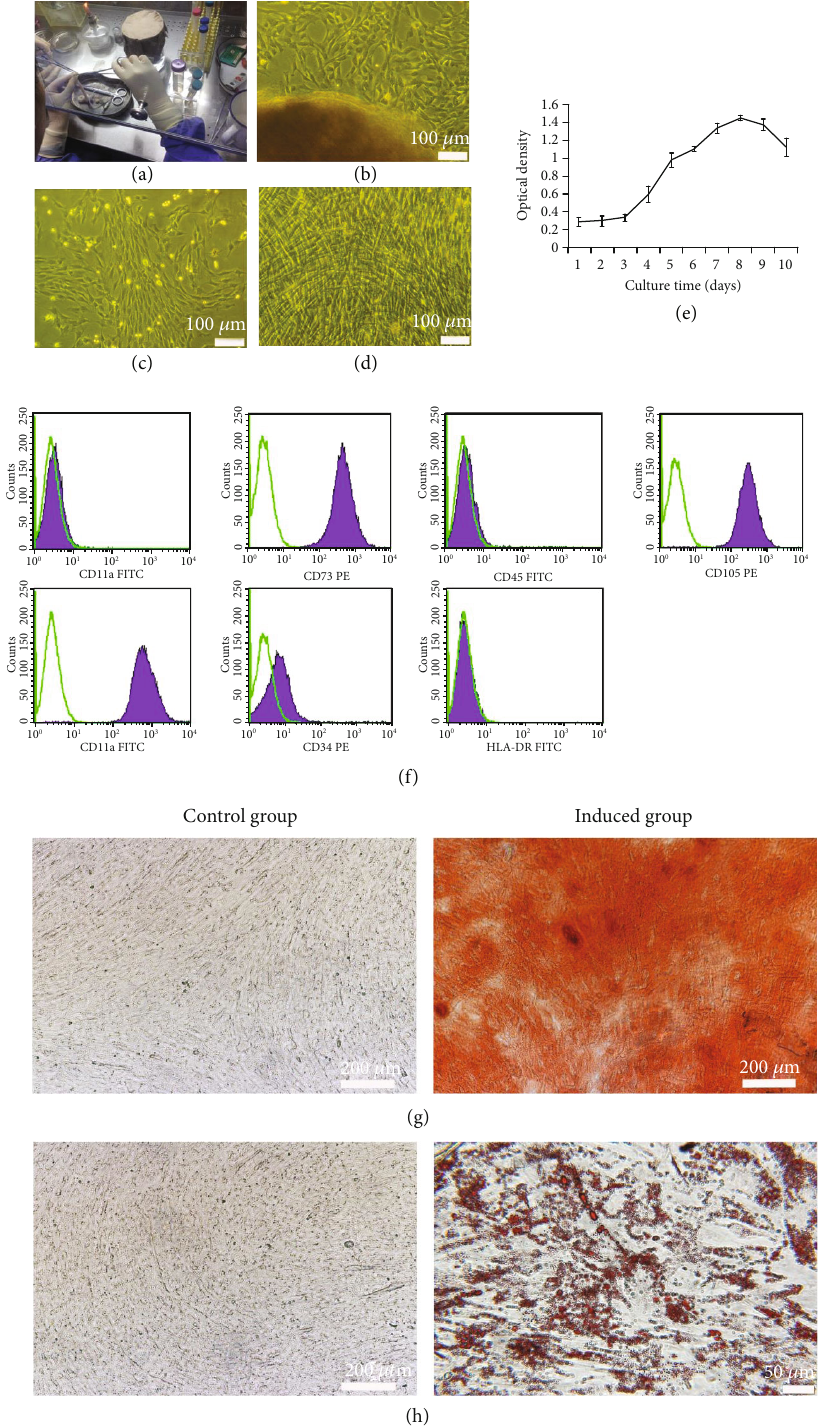
Figure 2: Characteristics of hUC-MSCs. (a) Umbilical cord. (b) Tissue explant culture of hUC-MSCs ( scalebar = 100 μ m ). (c) Phase 3 hUC- MSCs on day 1 of culture ( scale bar = 100 μ m ). (d) Phase 3 hUC-MSCs on day 4 of culture ( scalebar = 100 μ m ). (e) Proliferation of hUC- MSCs was evaluated using a CCK-8 assay ( mean ± SD , n = 12 ). (f) Phenotype of hUC-MSCs. Green line indicates isotype control; purple- shaded histograms indicate positive staining. (g) Alizarin red staining on day 21 of culture ( scale bar = 200 μ m ). (h) Oil red O staining on day 21 of culture (control group scalebar = 200 μ m , induced group scale bar = 50 μ m